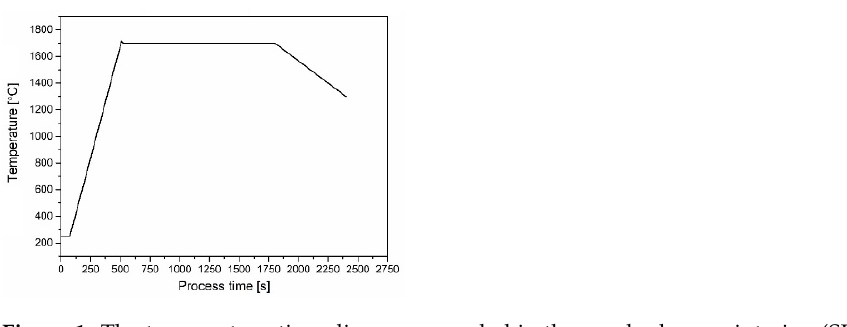
Figure 1. The temperature-time diagram recorded in the spark plasma sintering (SPS) apparatus during the process.